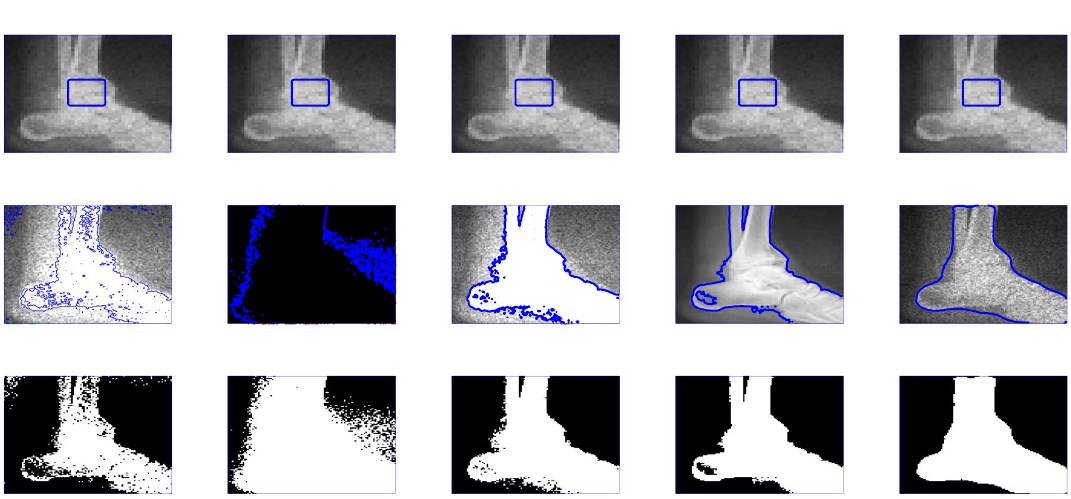
Figure 6. First, second, third and fourth columns are the segmentation results of Wu et al. 24 , Li et al. 15 , Wu et al. 12 and Krinidis et al. 31 , respectively. The fifth column is the segmentation result of proposed model with p=0.6, µ =0.7, σ =3, and noise =